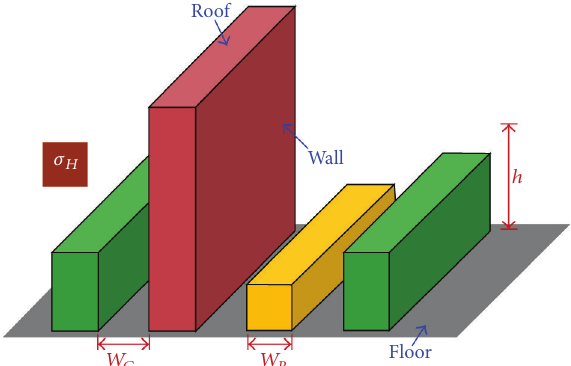
Figure 1: Schematic representation of the urban canyon geometry in WRF-UCM. 𝑊 𝑅 is the width of building, 𝑊 𝐺 is the width of street, ℎ is the average building height, and 𝜎 𝐻 is the building height